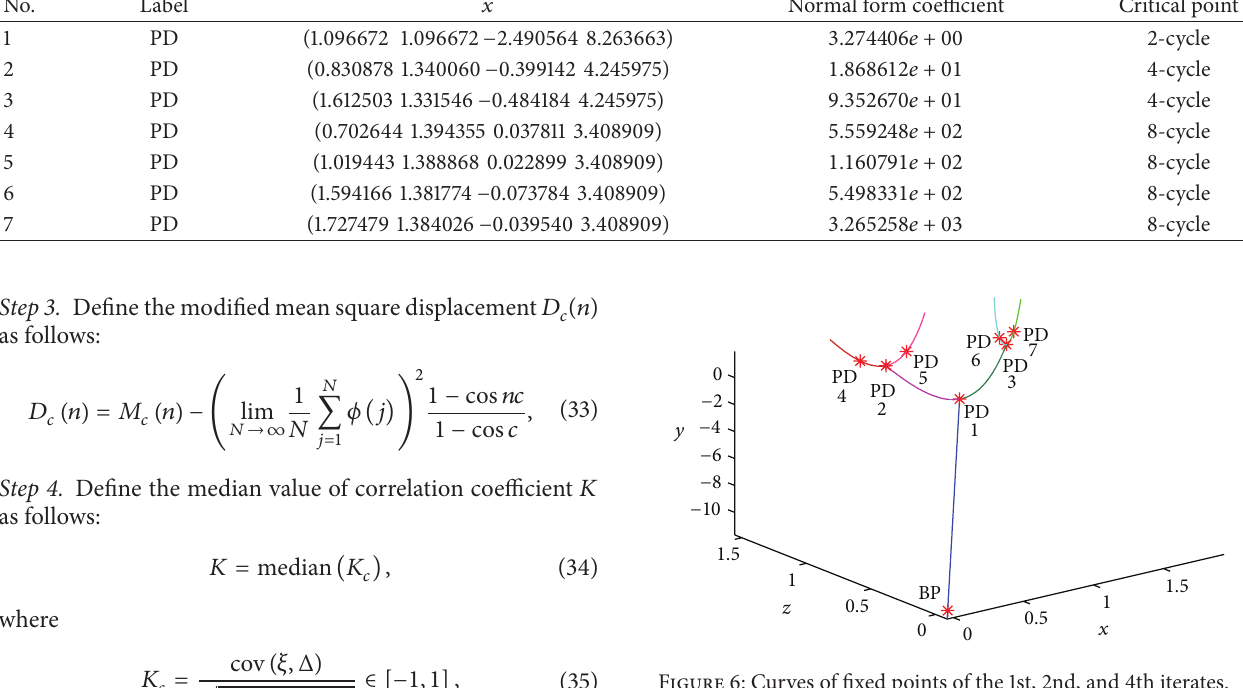
Figure 6: Curves of fixed points of the 1st, 2nd, and 4th iterates.